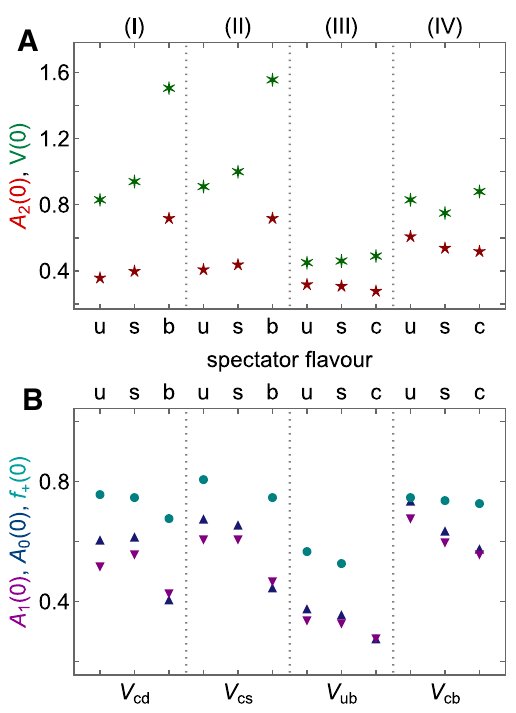
Fig. 9 SCI predictions for the transition form factor spectator current- mass dependence at maximum-recoil, labelled by the transition class defined when opening Sect.6. A A 2 ( 0 ) – red 5-point stars; V ( 0 ) – green V ( 0 ) is plotted in the b -quark column for V cd , V cs . 6-points stars – 1 2 Panel B . A 1 ( 0 ) – purple down-triangles; A 0 ( 0 ) – blue up-triangles; f + ( 0 ) in analogous pseudoscalar-to-pseudoscalar transitions [6] – teal circles